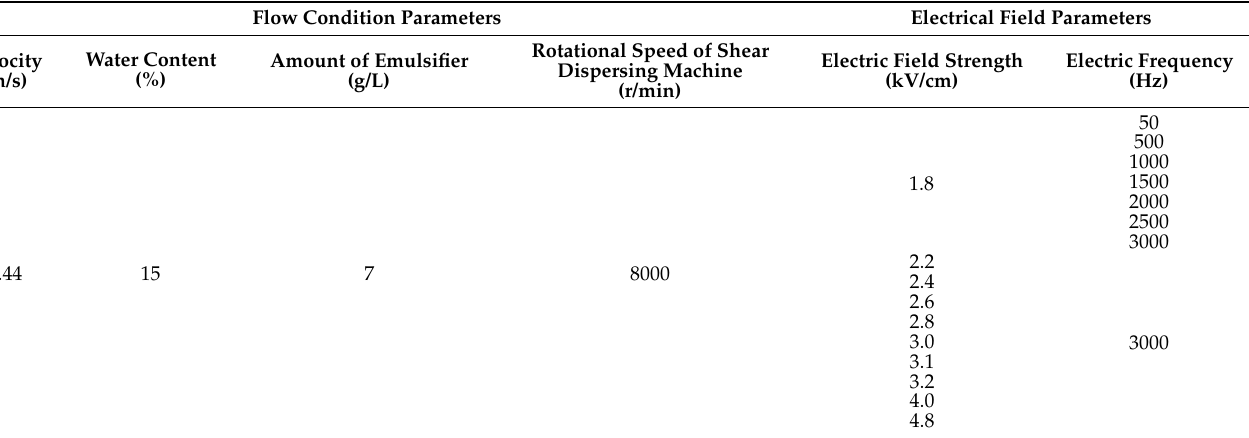
Table 3. Parameters to study the influence of electric